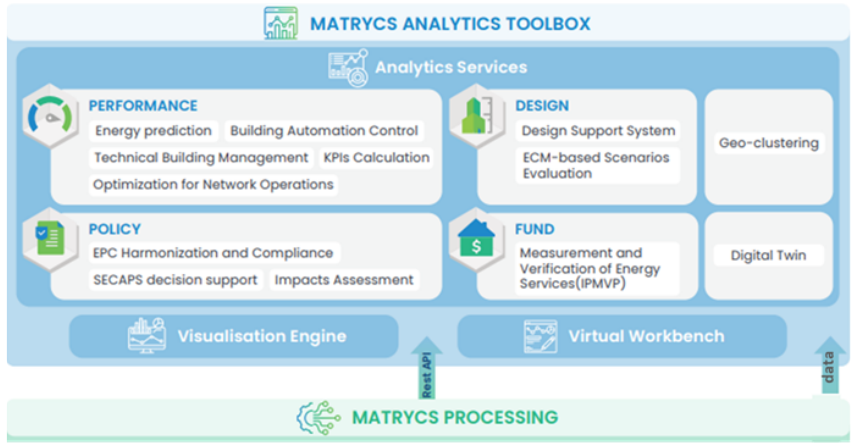
Figure 6. MATRYCS analytics layer architecture and development.